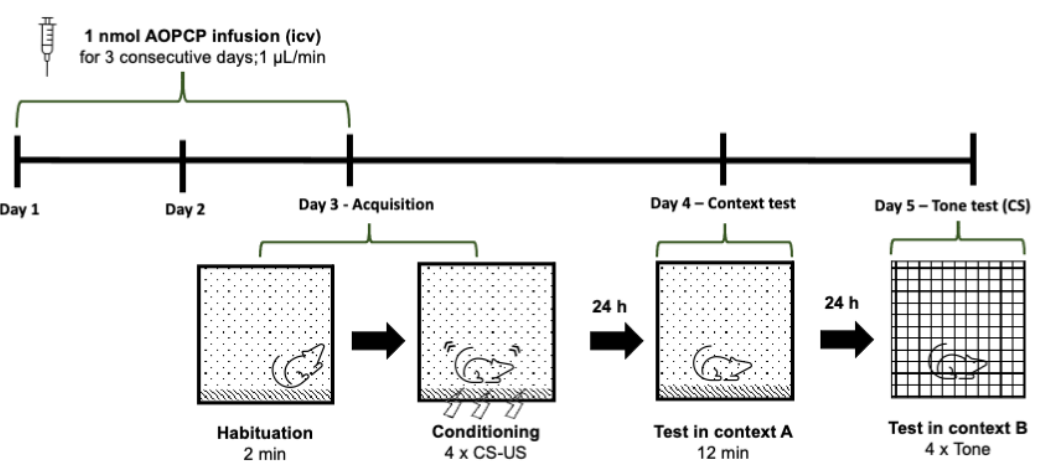
Figure 1. Schematic presentation of the fear conditioning protocol. AOPCP (1 nmol per ventricle) or vehicle were infused into both lateral ventricles (icv) of mice at a rate of 1 µL/min, once a day, throughout 3 consecutive days. On day 3, 1 h after icv infusion and after a habitation period of 2 min in the conditioning chamber (context A), mice were cued-fear conditioned (a tone (CS) of 80 dB was presented during 20 s and terminated with a footshock (US) of 0.5 mA and 2 s duration; 4 CS–US pairings were presented at 140 s intervals). On day 4, 24 h after fear conditioning, mice were re-exposed to context A during 12 min to probe for contextual fear memory. On day 5, cued-fear memory was tested in a different context (context B) for 12 min by presenting the tone 4 times at 140 s intervals after a 2 min habituation period.